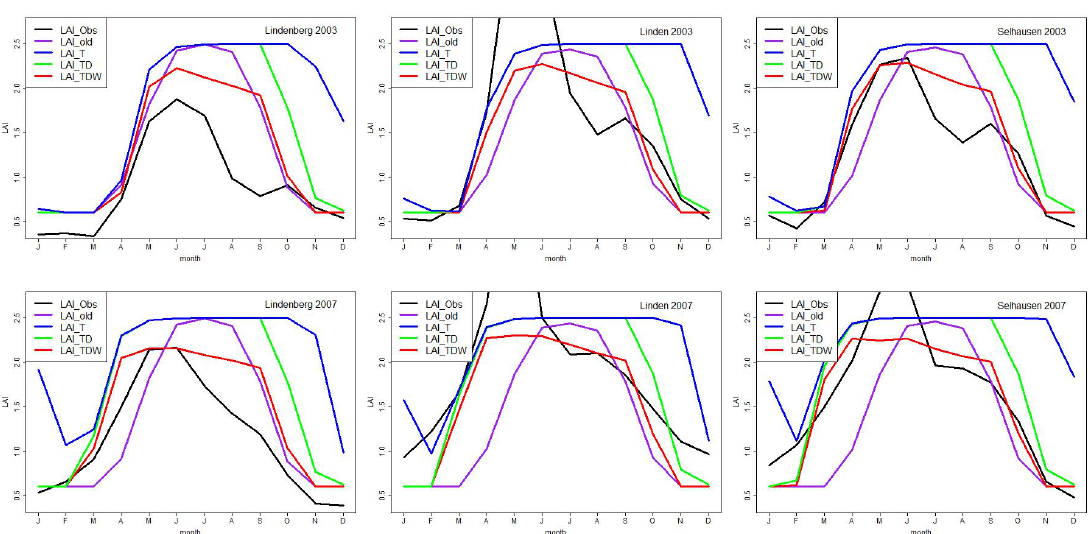
Figure 5. Annual cycle of LAI of the year 2003 with extremely dry summer ( top ) and the year 2007 with extremely warm spring ( bottom ) at Lindenberg ( left ), Linden ( middle ), and Selhausen ( right ). In black (–) are the satellite observations (_Obs) and in different colors the simulations with the standard phenology (_old, –), with only the dependence on temperature (_T, –), the dependence on temperature and day length (_TD, –), and with the new phenology (_TDW,